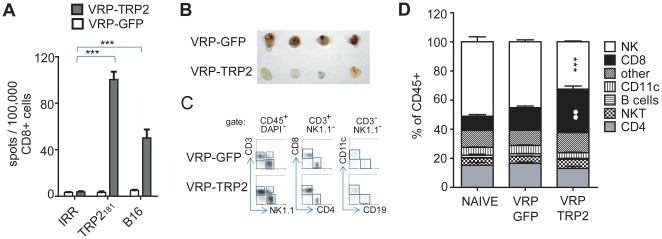
VRP-TRP2 elicits a tumor-specific CD8+ T cell responses.(A) ELISPOT analysis of IFNγ secreting CD8+ T cells purified from spleens of mice immunized with control VRP-GFP or VRP-TRP2 and re-stimulated with TRP-2181 peptide, B16 cells or an irrelevant peptide (IRR). Mean value and standard error represents 3/5 spleens analyzed individually per group. (B–D) Flow cytometric analysis of immune cell lineages infiltrating B16-matrigel plugs. (B) Representative photograph of B16-matrigel plugs of mice vaccinated with control VRP-GFP or VRP-TRP2 and (C) representative dot plot. (D) Immune infiltrate analysis expressed as a percentage of total CD45+ leukocytes. Mean percentage and standard error represent 4/5 tumors analyzed individually per group.